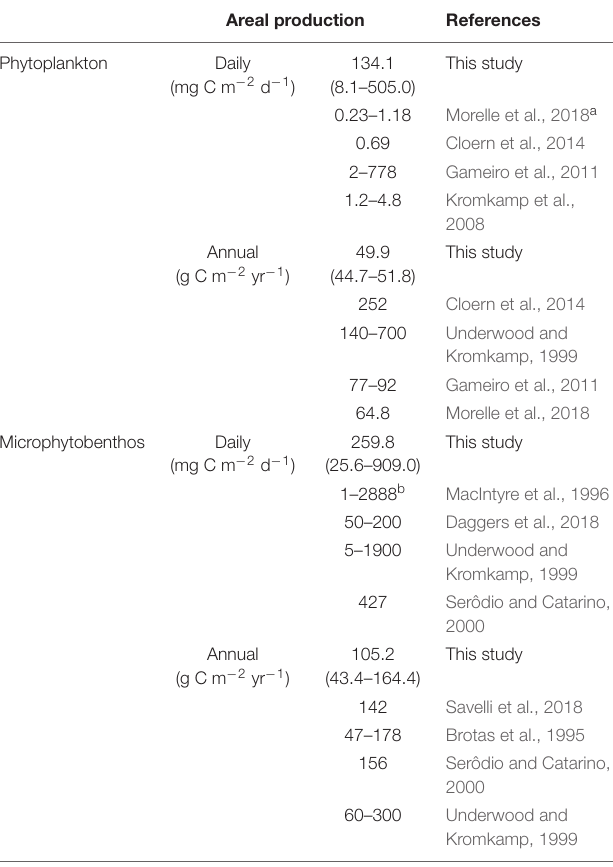
TABLE 3 | Daily and annual primary productivity rates of phytoplankton and microphytobenthos in published studies and as measured in this study (average and range of